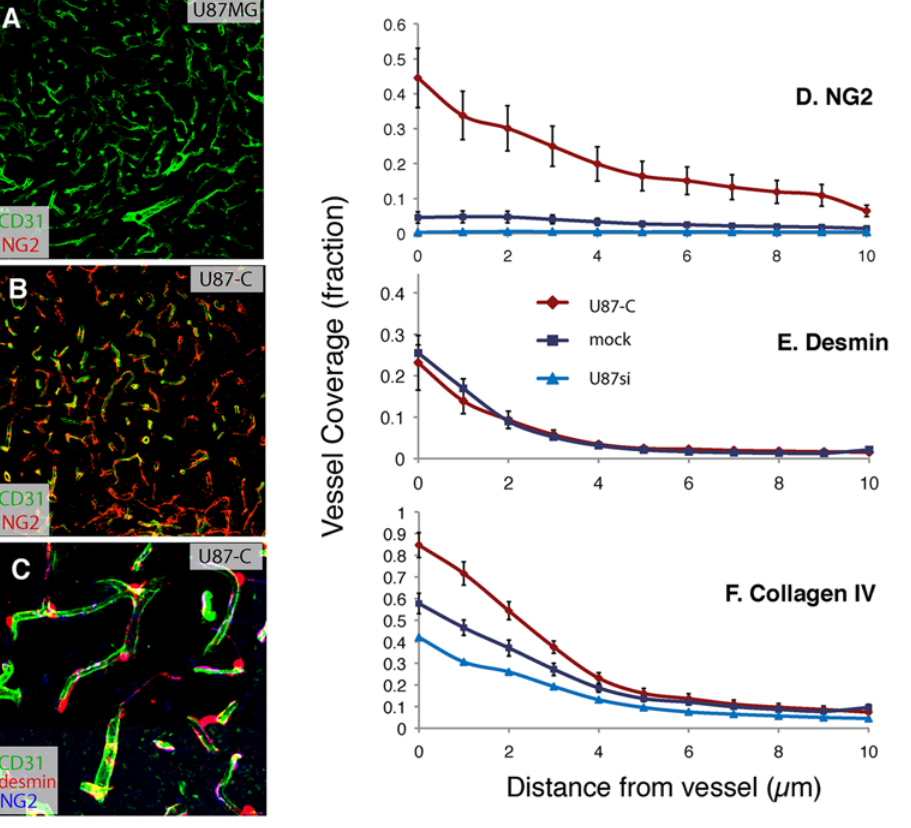
Figure 4. Changes in wall structure in response to PDGF-C overexpression. NG2 expression detected by confocal imaging of U87MG (A) and U87-C (B) tumors using immunohistochemistry on frozen sections of tumors harvested after 3 weeks post-implantation. Red pseudocolor represents NG2 positive cells, green pseudocolor represents CD31 positive endothelial cells. Panel C shows staining for NG2 (blue), desmin (red) and CD31 (green) on a 100 m m projection acquired with a confocal microscope. Panels D and E: quantification of NG2 and desmin, respectively. PDGF-C expression does not affect desmin-positive cell recruitment, but dramatically increases the number of NG2-positive cells around vessels. F: collagen IV distribution around vessels. The basement membrane is typically thicker than normal in U87MG [24] but U87-C displays an even thicker basement membrane.